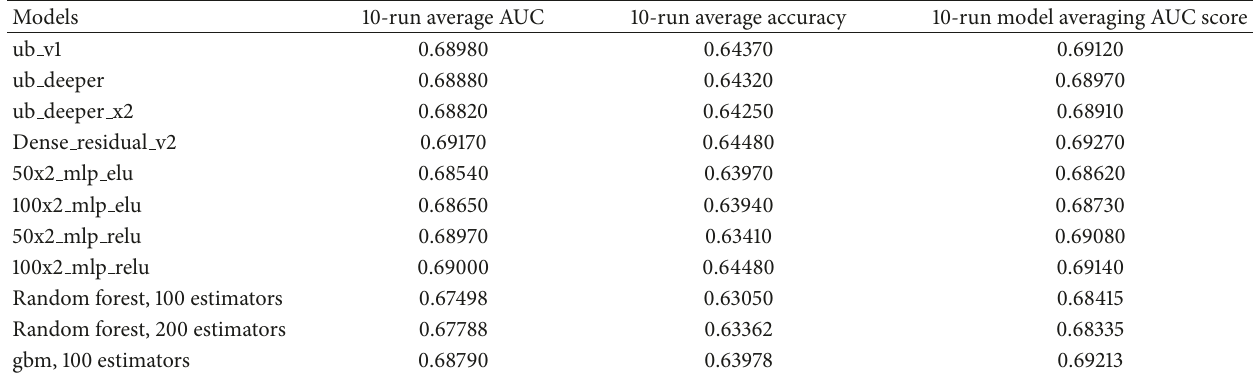
Table 5: Classifier performance on dataset